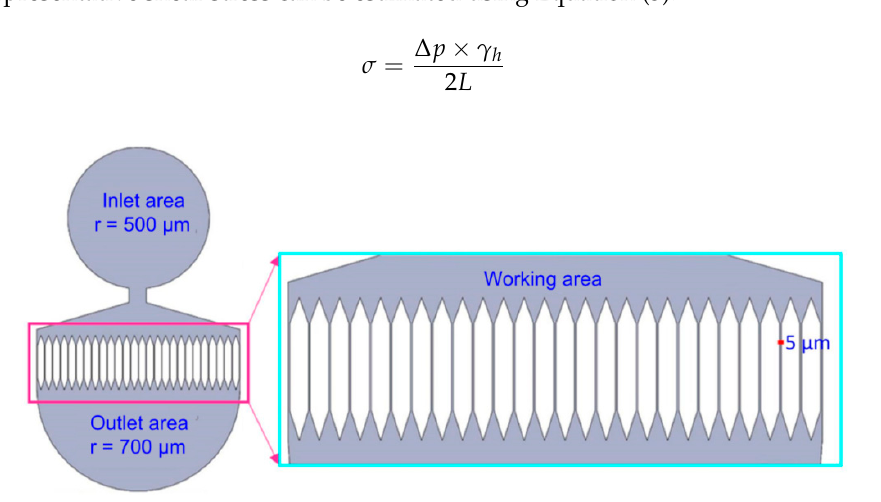
Figure 1. Schematic of the proposed microfluidic device for extracting mitochondria.